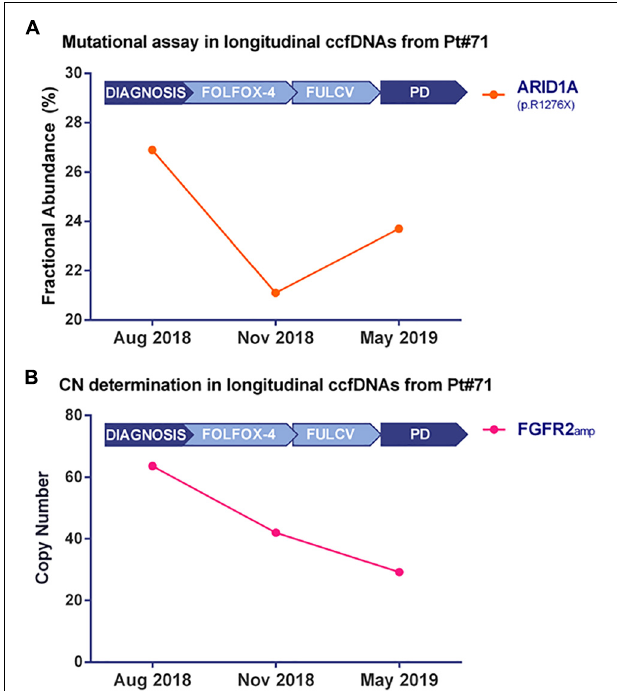
FIGURE 4 | Kinetics of mutated fractional abundance and CNV in longitudinal ccfDNAs measured by Droplet Digital PCR. The graph in (A) illustrates ARID1A mutated fractional abundance (p.R1276X) during patient’s follow-up. This value decreases during treatment and later rises at the worsening of patient’s conditions; on the contrary, when monitoring FGFR2 amplification at the same time points, as reported in (B) , a decreasing trend was detected from the diagnosis to disease